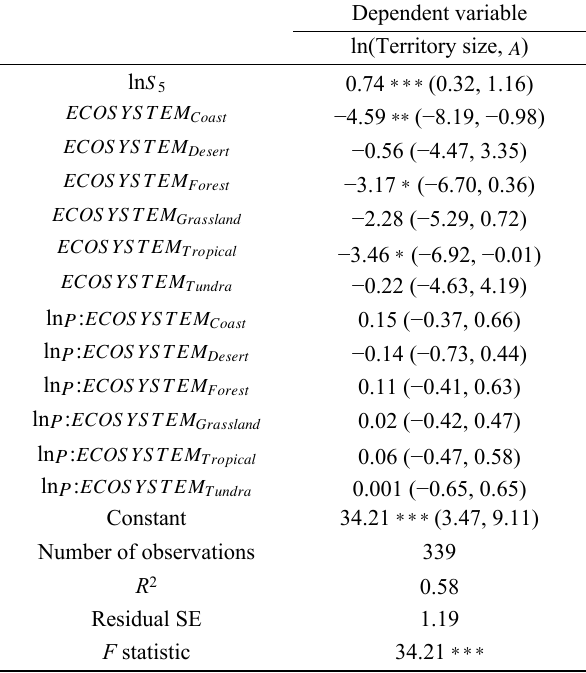
Table 6 Linear model of hunter-gatherer territory size by population size and ecosystem